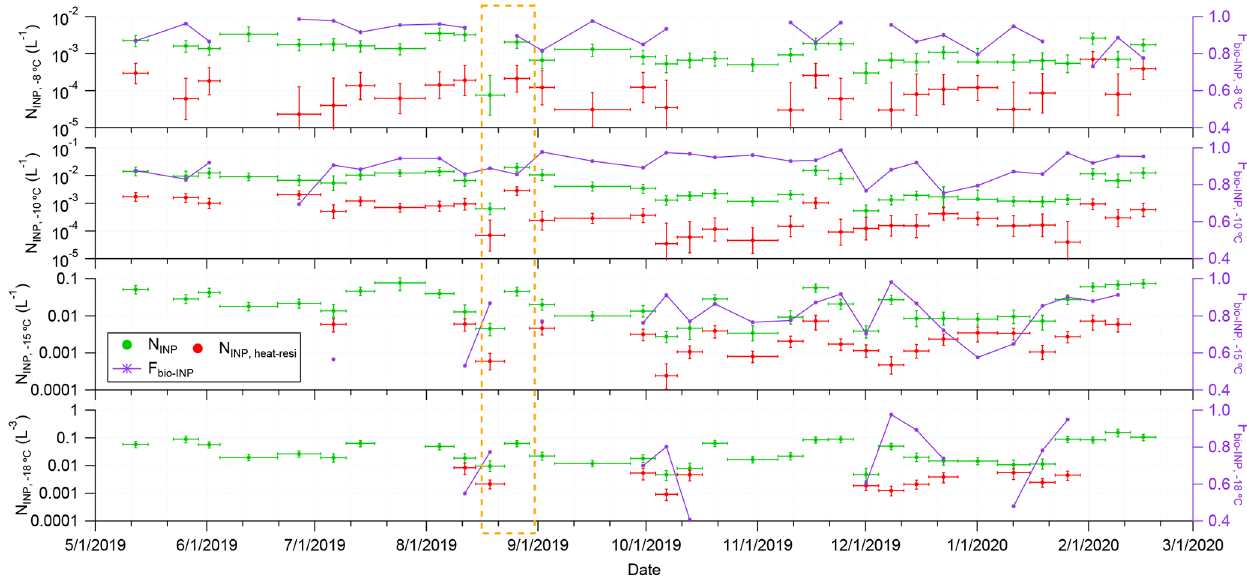
Figure 2. Time series of N INP (green dots) and heat-resistant N INP ( N INP, heat_resi , red dots) at − 8, − 10, − 15, − 18 ◦ C (from top to bottom). The fraction of bio-INP is shown as a purple line. The orange box highlights samples 11 and 12, i.e., the two samples used for a case study (discussed in Sect.